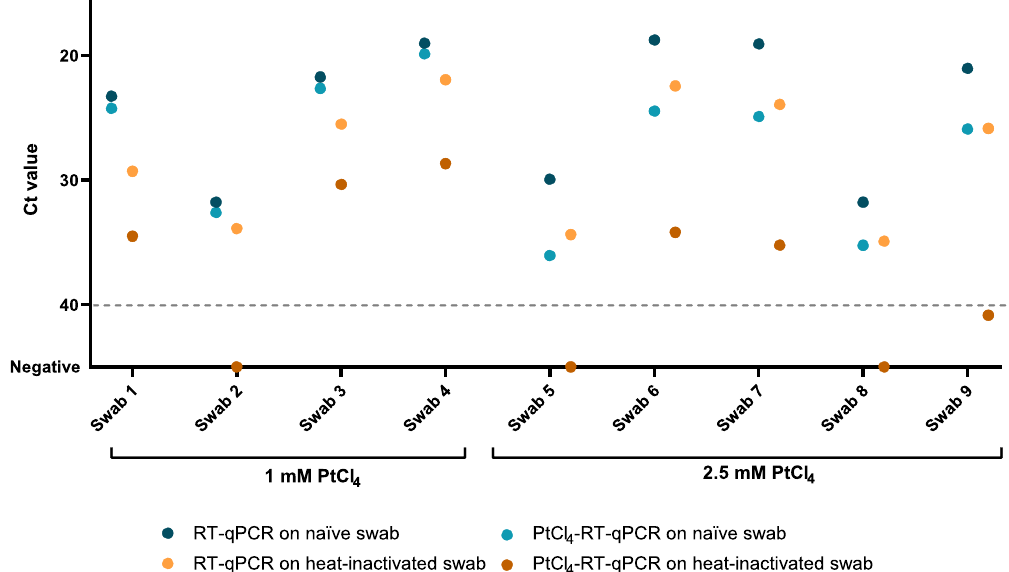
Figure 4. Validation of viability RT-qPCR with either 1 mM or 2.5 mM PtCl 4 on ten-fold diluted nasopharyngeal swabs from COVID-19 positive patients. Plotted dots represents the median cycle threshold value (Ct) of naïve and heat-inactivated (95 °C for 10 min) subsamples assayed by RT-qPCR alone and viability RT-qPCR both targeting N1. Dashed grey line represents RT-qPCR theoretical limit of detection.